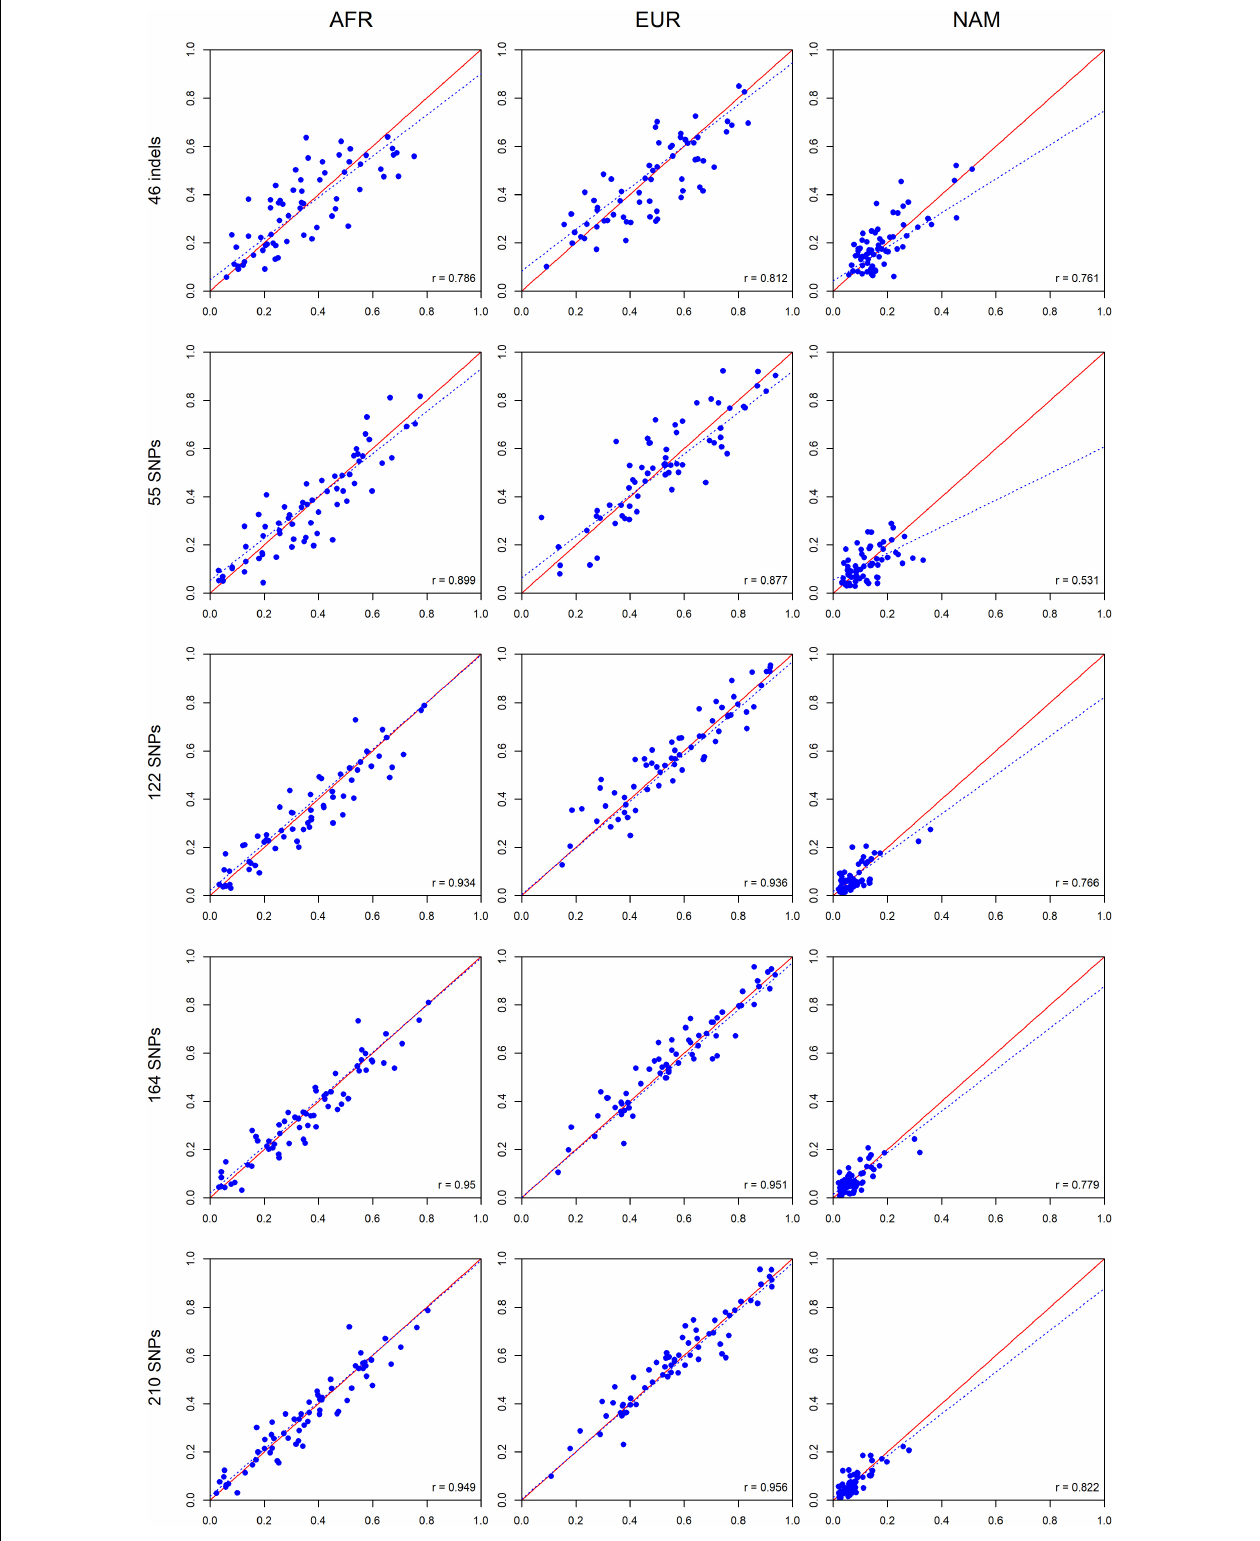
FIGURE 12 | Comparisons between the ancestry estimates for siblings pairs based on the five AIM panel. The respective r -values are indicated in the figures, and the tendency line is represented as a blue dashed line. The red solid line indicates the perfect agreement between two AIM panels.